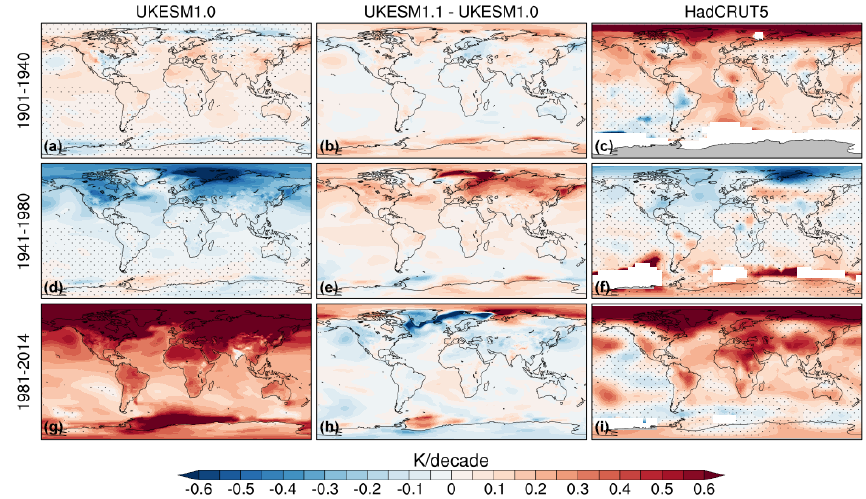
Figure 4. Surface temperature trends in (a, d, g) UKESM1 and (c, f, i) HadCRUT5 (Morice et al., 2021) and (b, e, h) the UKESM1.1- UKESM1 difference for the periods (a–c) 1901–1940, (d–f) 1941–1980 and (g–i) 1981–2014. Regions where trends are not significant are